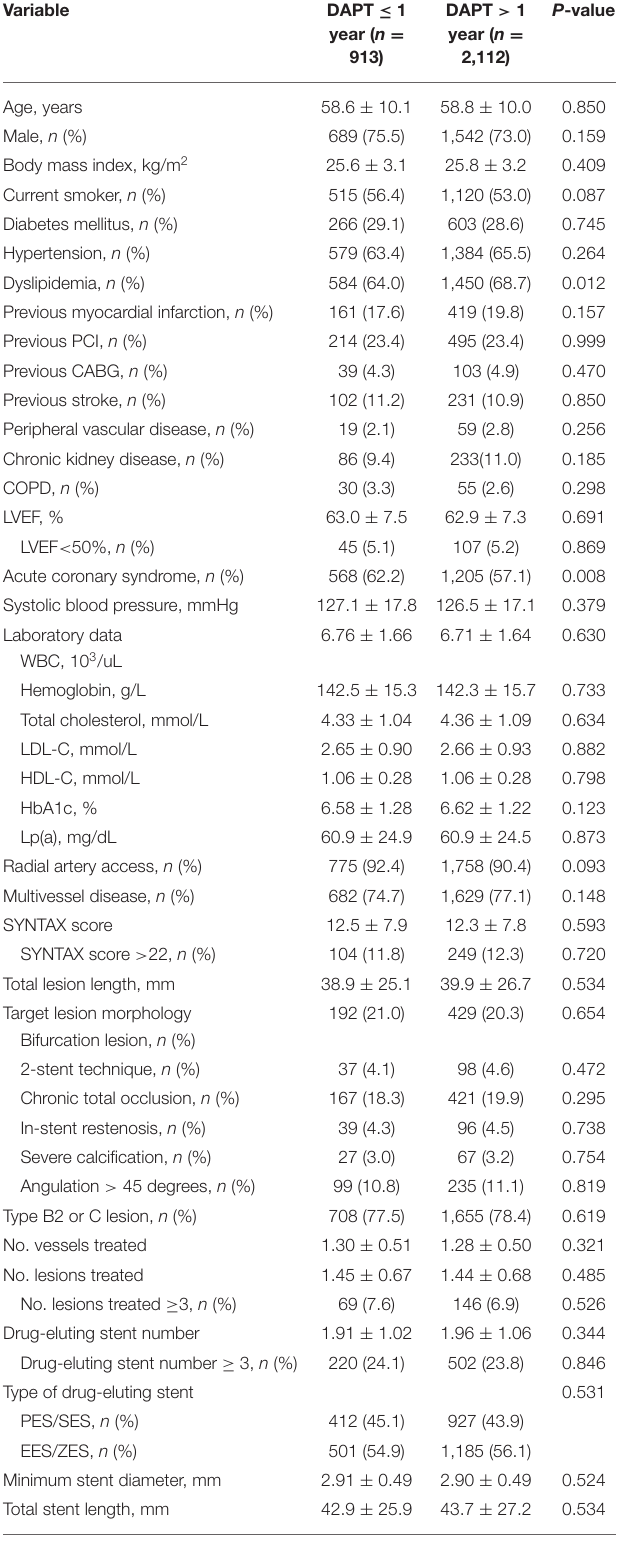
TABLE 1 | Baseline patient, angiographic, and procedural characteristics according to DAPT time.